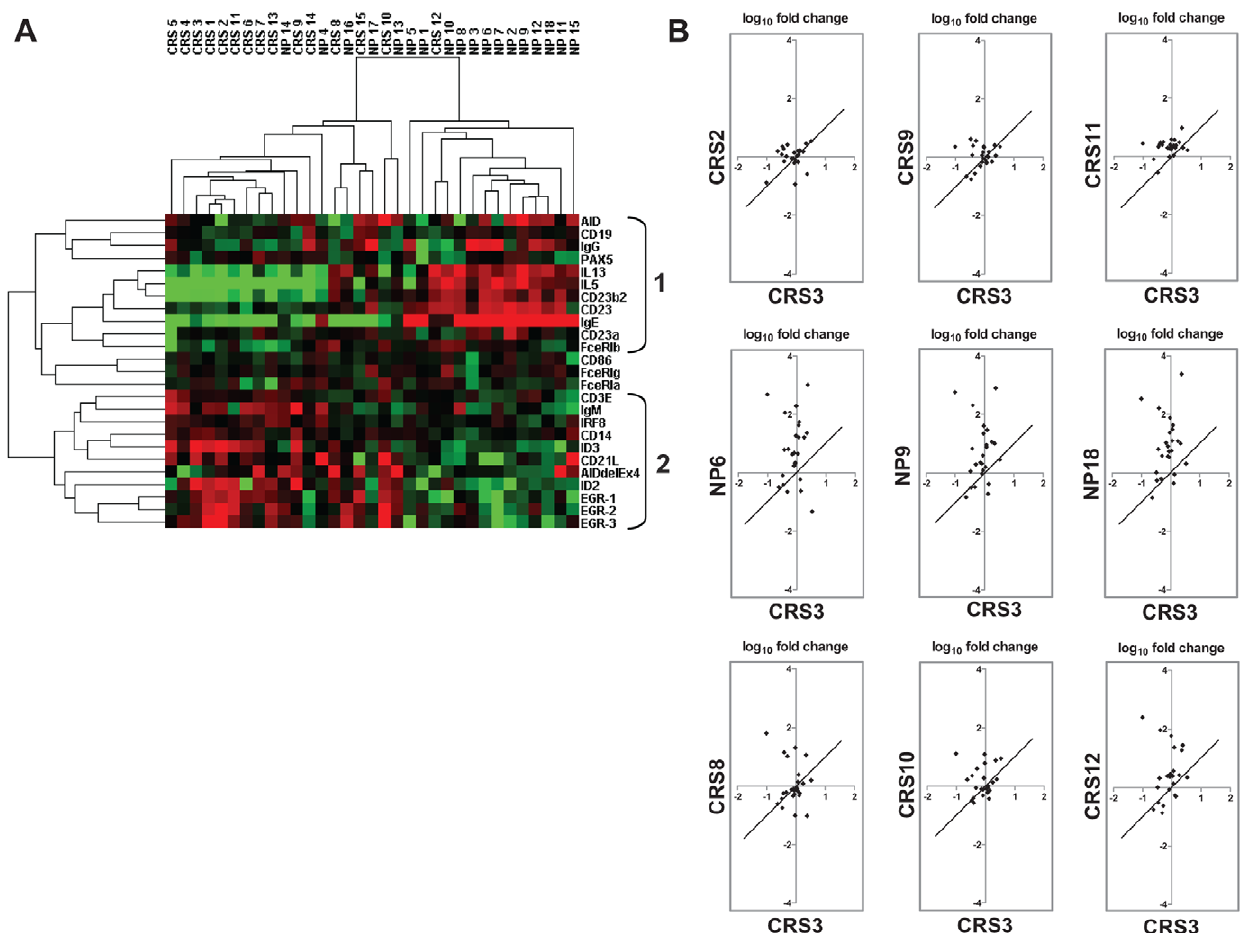
Figure 4. Hierarchical clustering of expression datasets and scatter plots of patient-orientated profile. (A) The subset of 25 genes was analyzed against a dataset derived from the real-time PCR-based profiling of a panel of 33 specimens from patients with chronic rhinosinusitis with nasal polyps (NP; n=18) in comparison to the one without nasal polyps (CRS; n=15); Pearson uncentered hierarchical clustering was applied. Shown is a result of a clustering run representing a pair of trees, one for genes and one for arrays/samples (Cluster/TreeView programs). Sub-signatures 1 and 2 orchestrated around AID and IDs/AID- D ex4 (AIDdelEx4 here), respectively, are indicated. Color code: red indicates induction and green - repression; according to Cluster/TreeView [50], color hue does not reflect the exact magnitude of gene alteration. (B) log transformation plots represent the patient-orientated gene expression ‘‘fingerprint’’; the figure depicts the relative expression level of each gene between CRS or NP specimens (y-axis) and CRS3 specimen (x-axis); axis – log scale. Representative scatter plots of three patients from the CRS group (CRS2, CRS9, CRS11) and three patients from the NP group (NP6, NP9, NP18) are shown. These specimens were selected from two main clusters, separating CRS and NP samples (Figure 4, A). Scatter plots of three CRS specimens (CRS8, CRS10, CRS12) from a mixed population are shown in